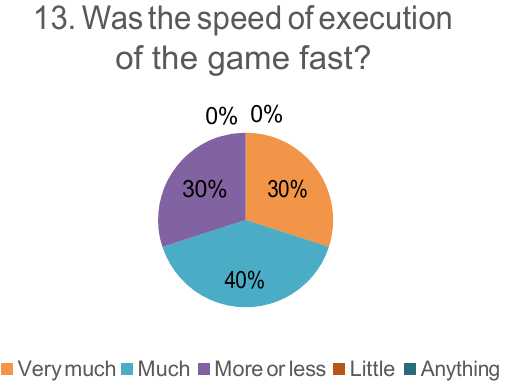
Figure 5. Skill with the game. Fig. 6. Game